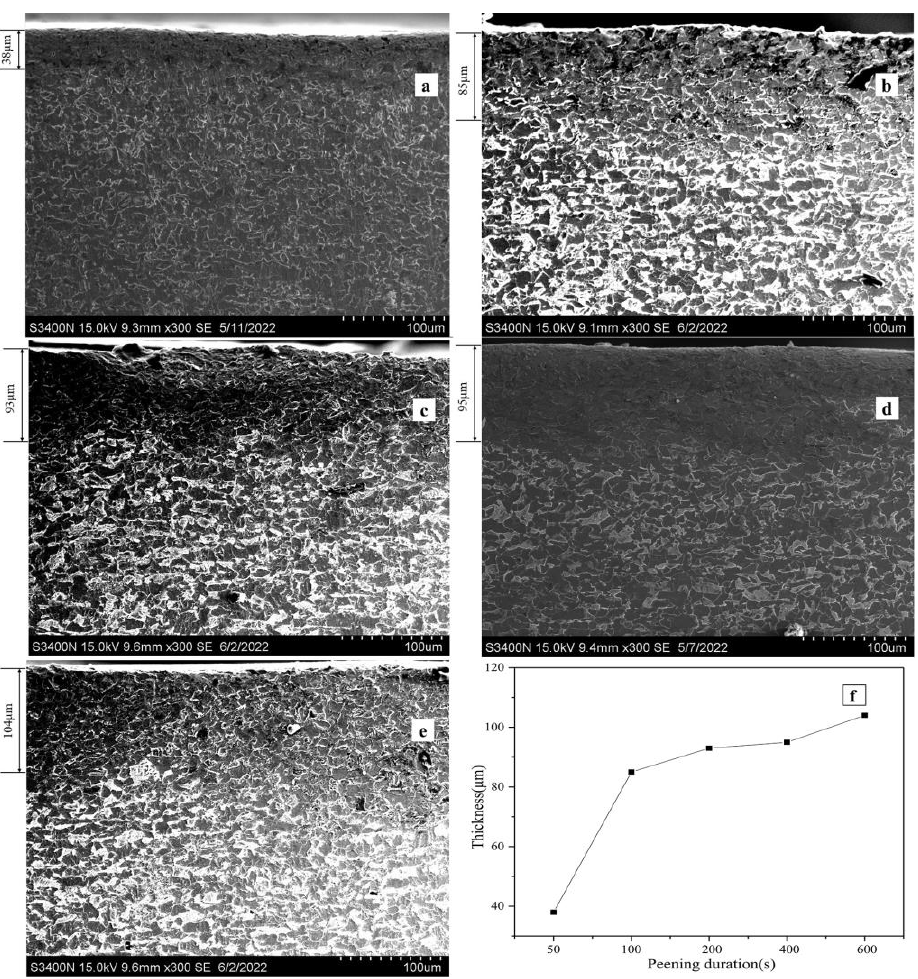
Figure 2. The cross-sectional SEM microstructure images of the 3 mm-2080 W-11 mm sample: ( a ) 50 s; ( b ) 100 s; ( c ) 200 s; ( d ) 400 s; ( e ) 600 s. ( f ) The thickness statistics of the shot peening deformation layer with different lengths of